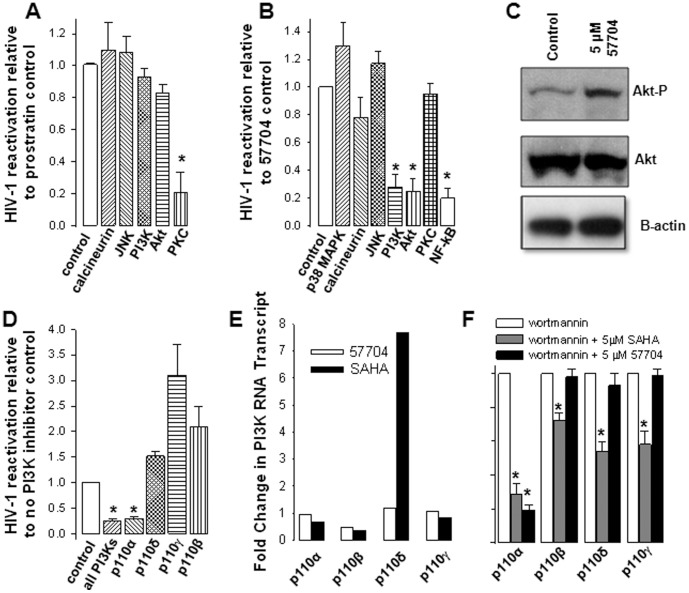
57704 reactivates latent HIV-1 via the PI3K/Akt signaling pathway.(A) Latent HIV-1 reactivation activity of prostratin in the absence (control) or presence of inhibitors of calcineurin (1 µM cyclosporin A), JNK (1 µM SP00125), PI3K (20 nM wortmannin), Akt (500 nM Akt Inhibitor IV) and PKC (500 nM Go6983). (B) Latent HIV-1 reactivation activity of 57704 in the absence (control) or presence of inhibitors of p38 MAPK (50 nM SB203580), calcineurin, JNK, PI3K, Akt, PKC and NF-κB (20 µM NF- κB activation inhibitor). (C) Western blot analysis of phosphorylated Akt in J89GFP treated with 5 µM 57704. (D) Latent HIV-1 reactivation activity of 57704 in the absence (control) or presence of a pan-inhibitor of PI3K (15 µM LY294002) or inhibitors targeting the p110α (2 µM PI-103), p110δ (5 µM IC87114), p110γ (2 µM AS-605240) or p110β (2 µM TGX-221) isoforms. (E) PI3K isoform transcript levels in cells treated with 5 µM 57704 or 5 µM 57704 SAHA.(F) Inhibition of the PI3K p110α, β, δ and γ isoforms by 100 nM wortmannin alone or in combination with 5 µM 57704 or 5 µM 57704 SAHA.